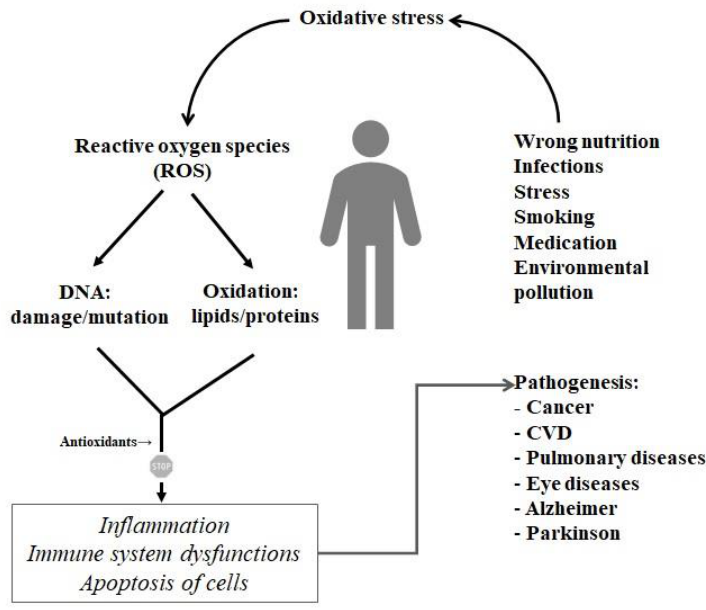
Figure 5. The preventive activity of antioxidants on the formation of diseases according to Sarmadi and Ismail